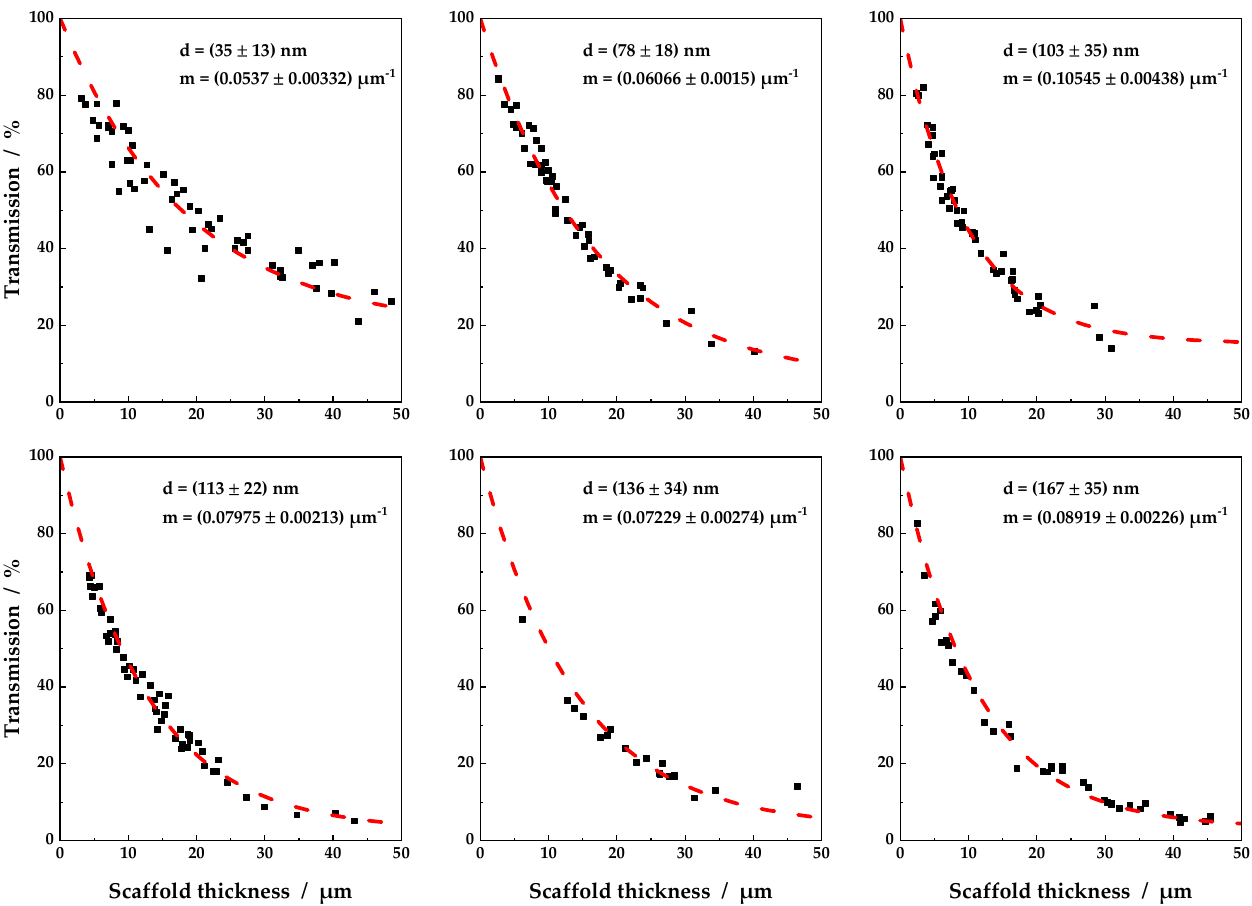
Figure 4. Examples of transmissions as a function of scaffold thickness for a discrete wavelength of 589 nm. Scaffolds were measured in ethanol as the surrounding medium. Fiber diameter increases from top left to bottom right. An exponential decay in light transmission was fitted using Equation (8).